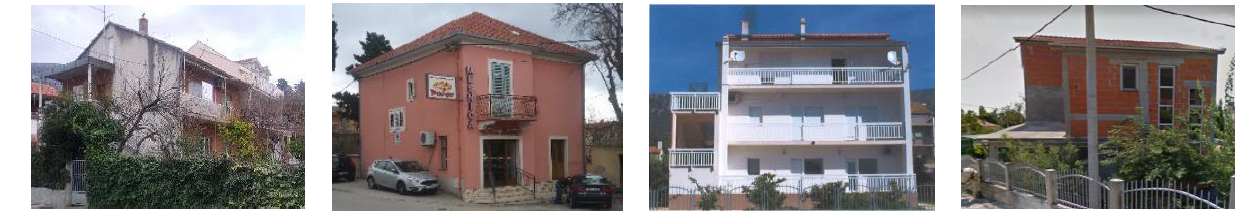
Figure 4. Buildings outside of the historical center.